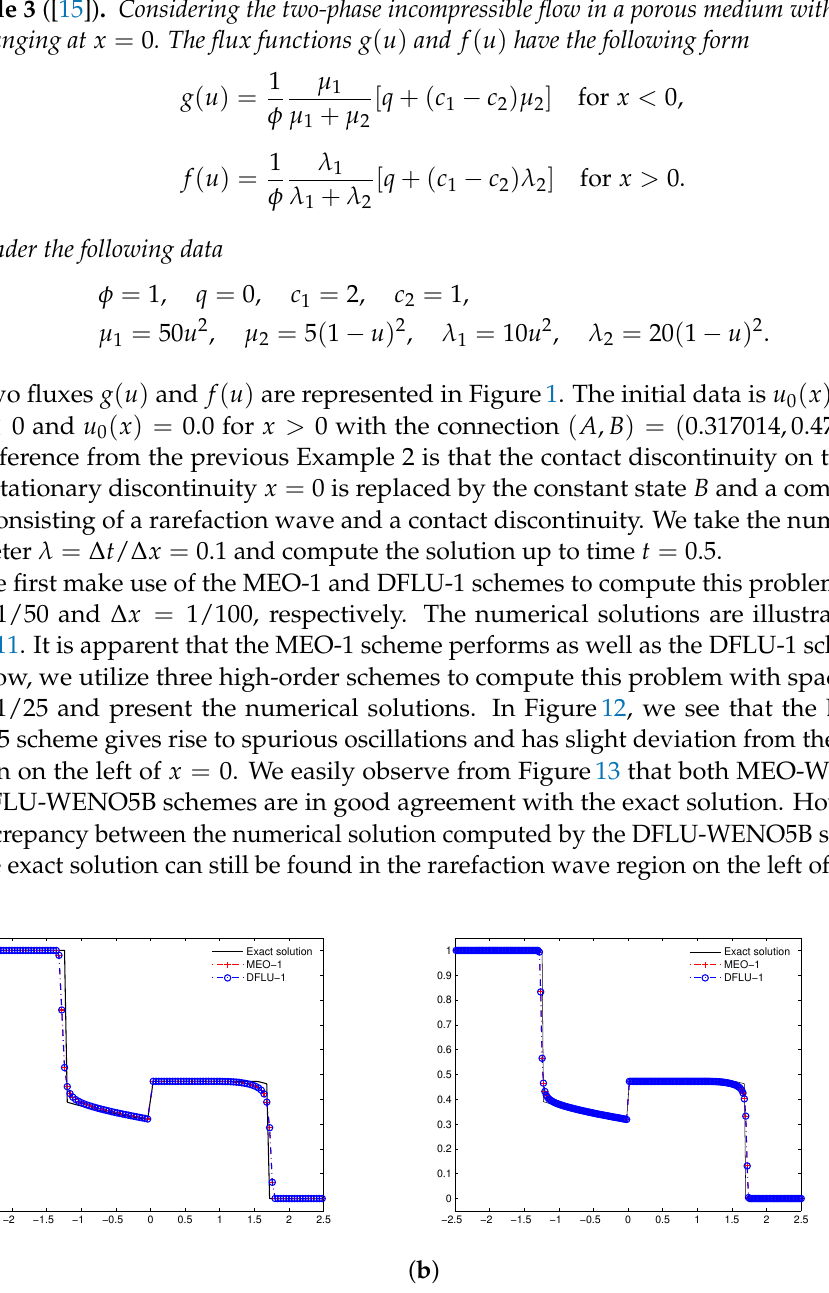
Figure 11. Example 3: Numerical solutions computed by the MEO-1 and DFLU-1 with the different meshes. ( a ): ∆ x = 1/50; ( b ): ∆ x =